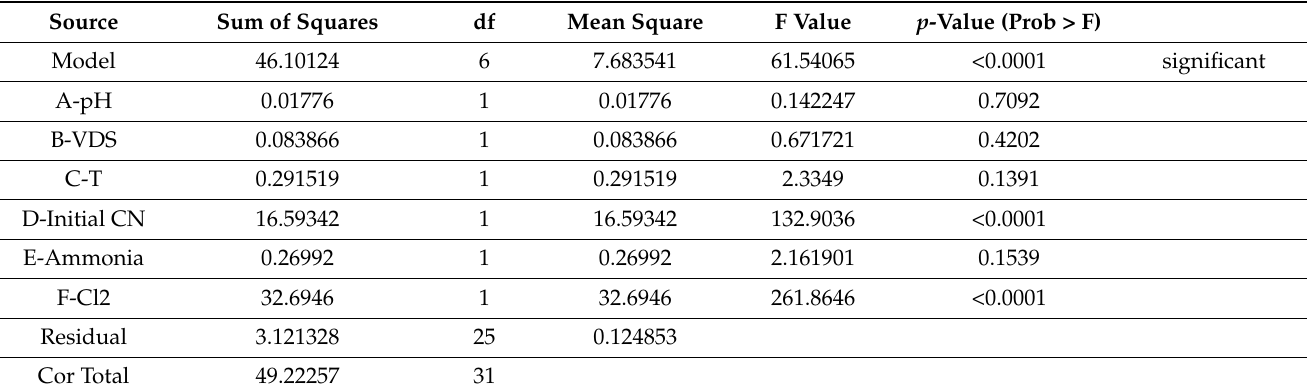
Table 4. The outputs of ANOVA method in the present research.